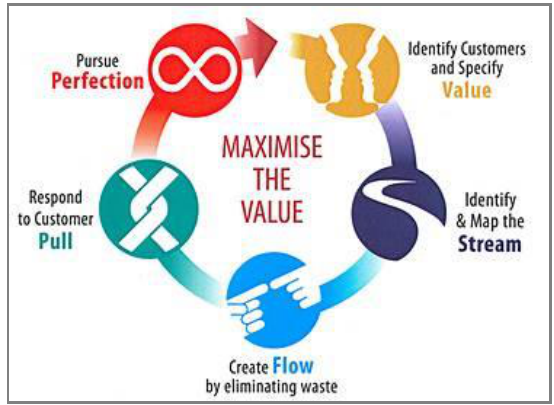
Figure 2. The principles of the LEAN